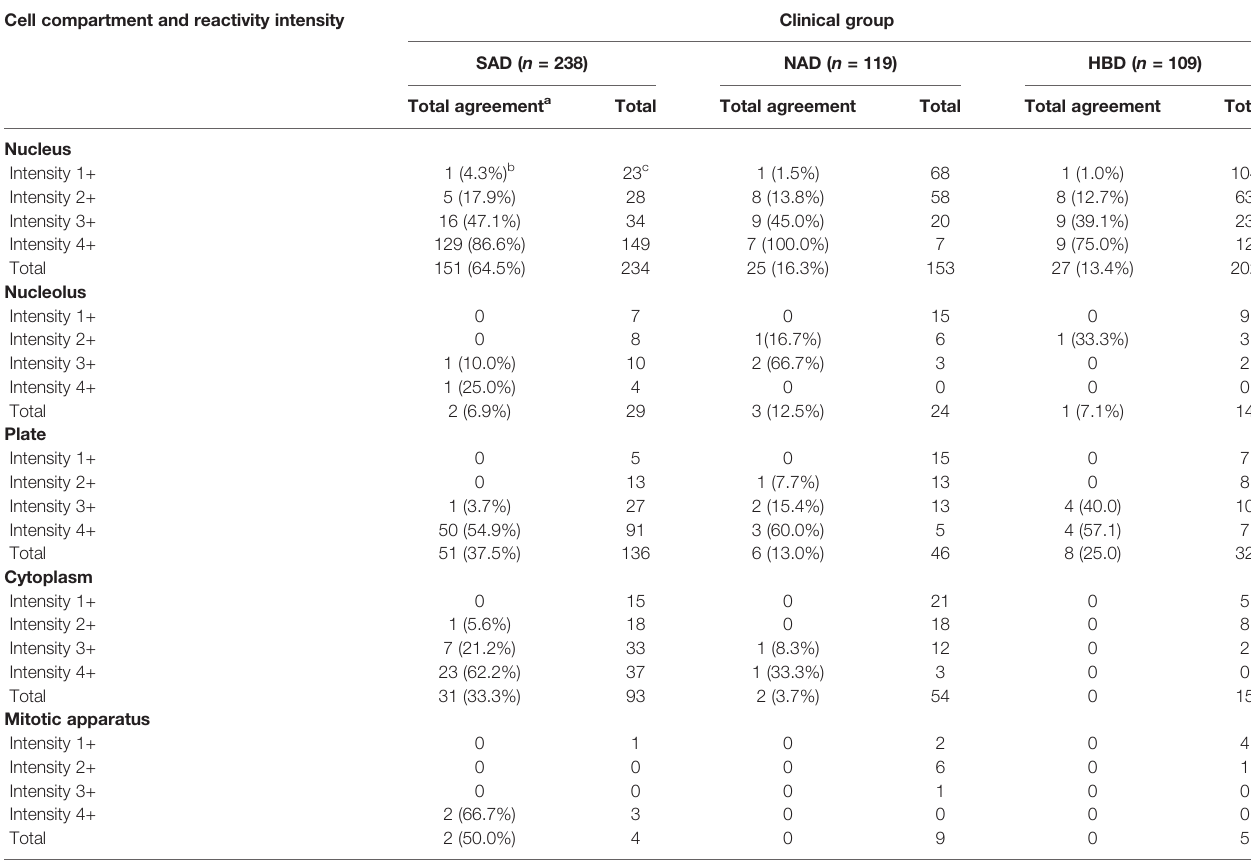
TABLE 3 | Distribution of reactive samples according to the reactivity intensity and total reactivity agreement in each cell compartment in the three clinical groups. Cell compartment and reactivity intensity